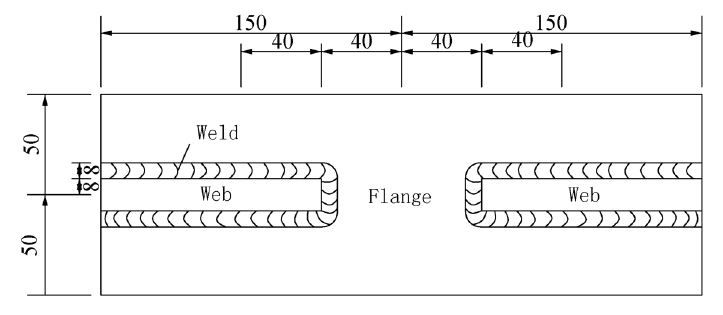
b) Figure 2. The geometry of the cope-hole details